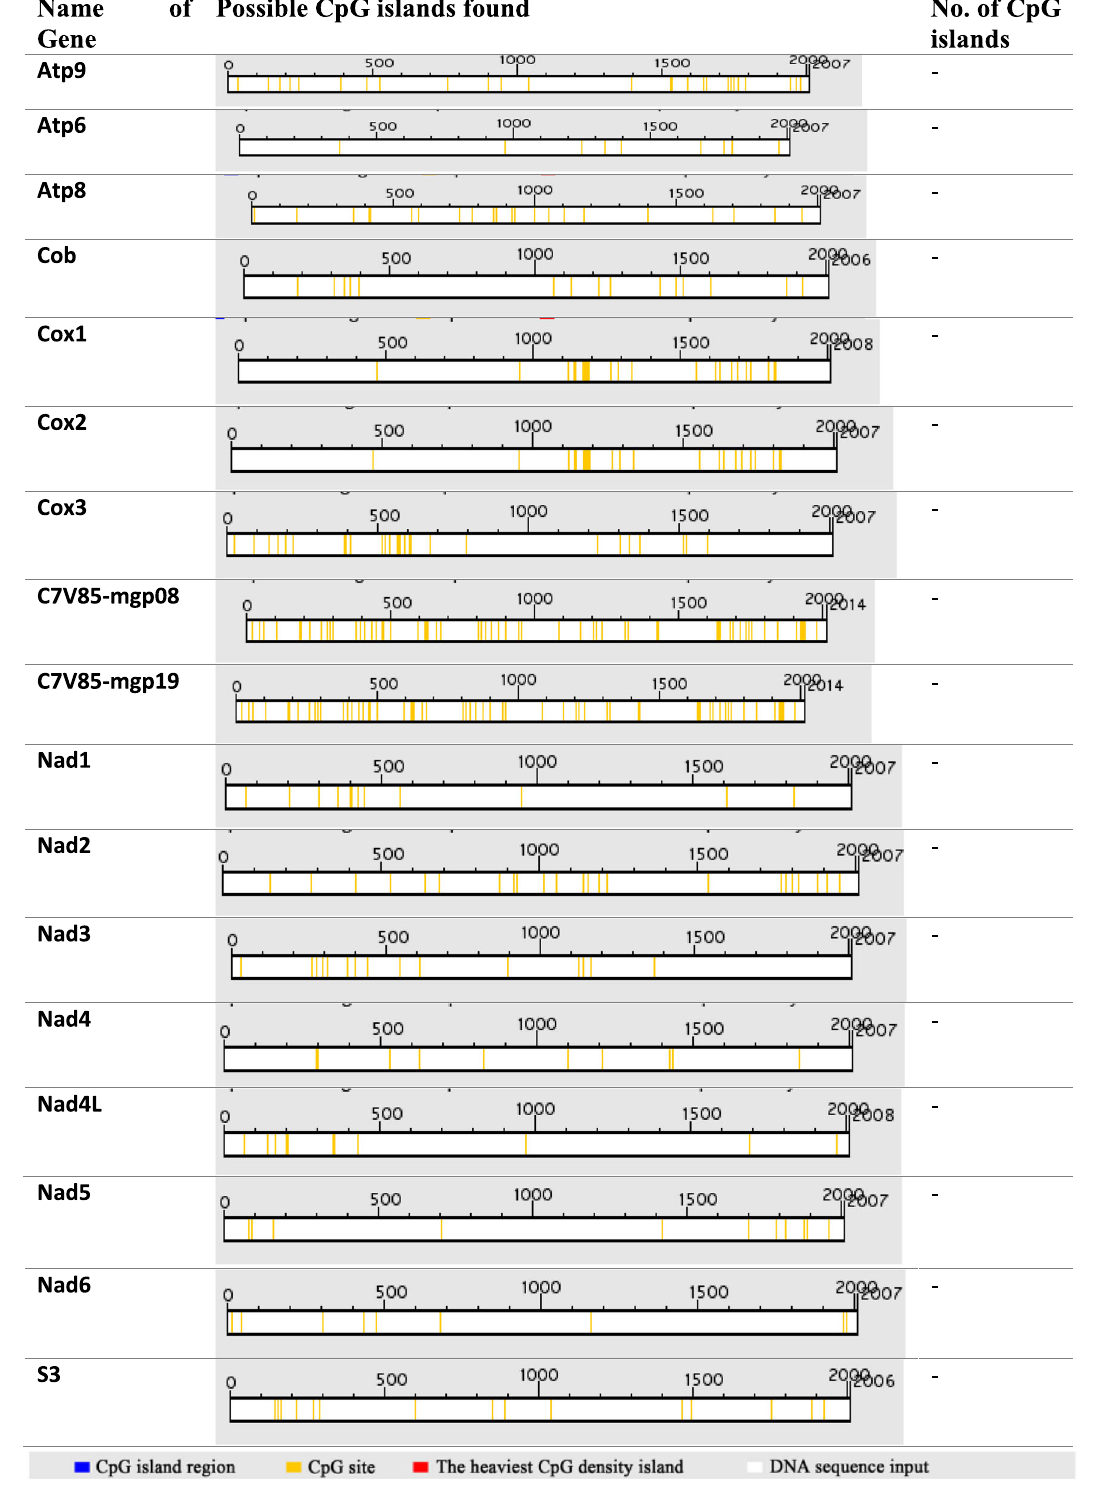
Table 4 Possible CpG islands in promoter regions using Takai and Jones ’